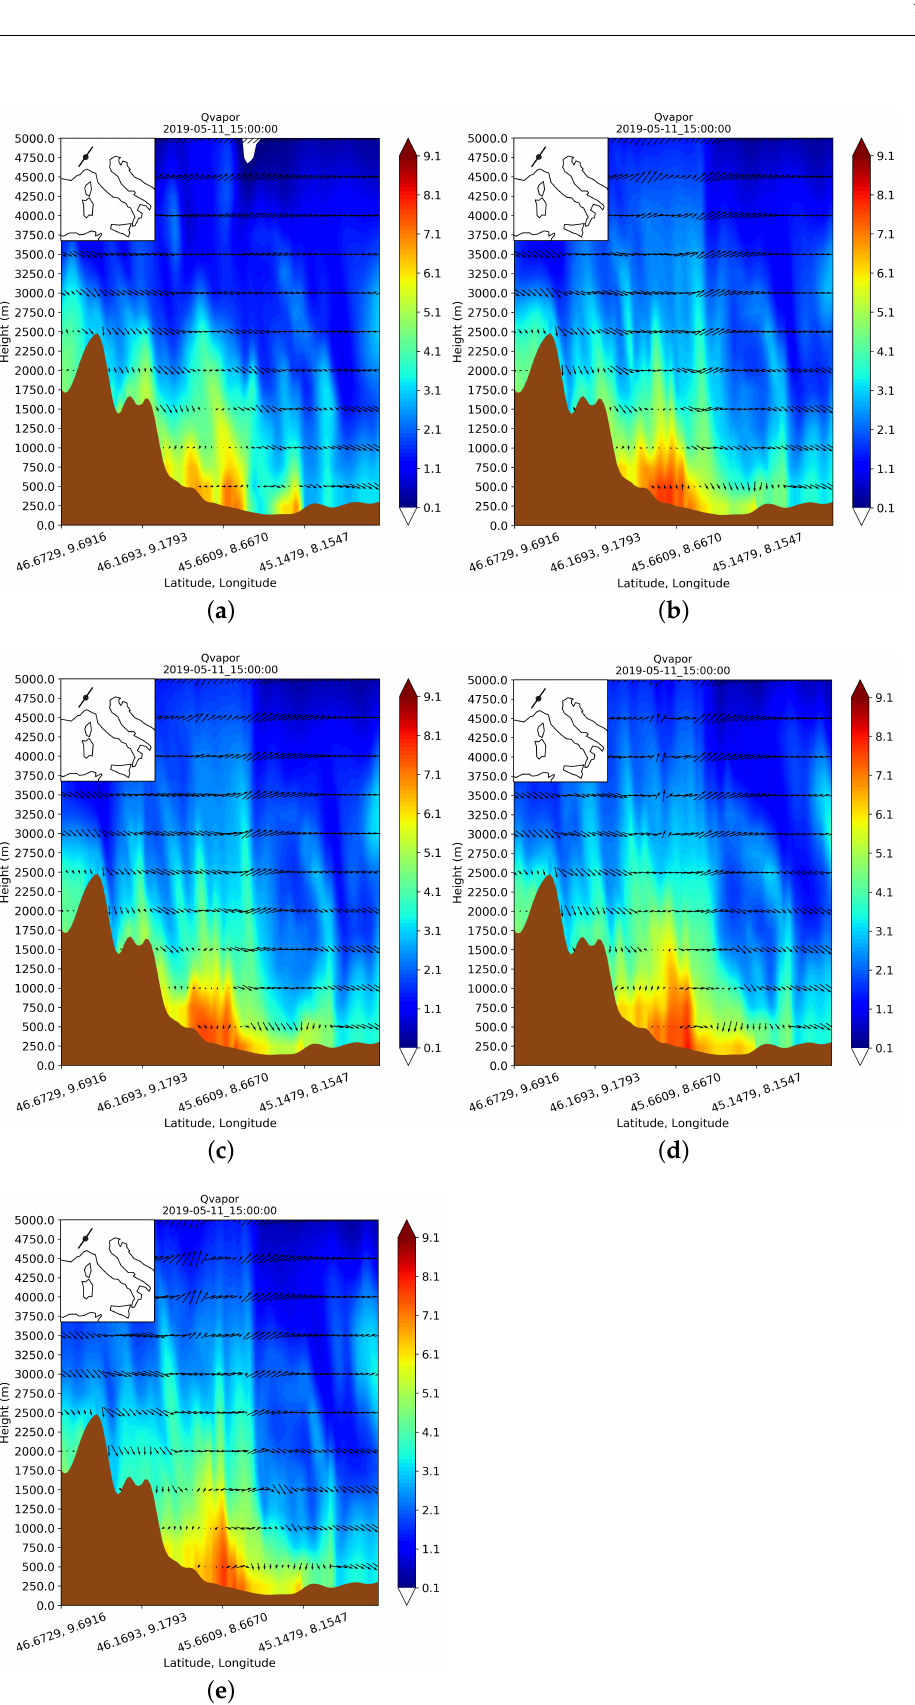
Figure 10. Vertical cross-sections of water vapor mixing ratio (qvapor, g kg − 1 ) through the squall line for the CTL ( a ), RDR-LIG ( b ), RDR-ZTD-LIG ( c ), RDR-TMP-LIG ( d ) and ALL ( e ) simulations at 15:00 UTC, 5 May